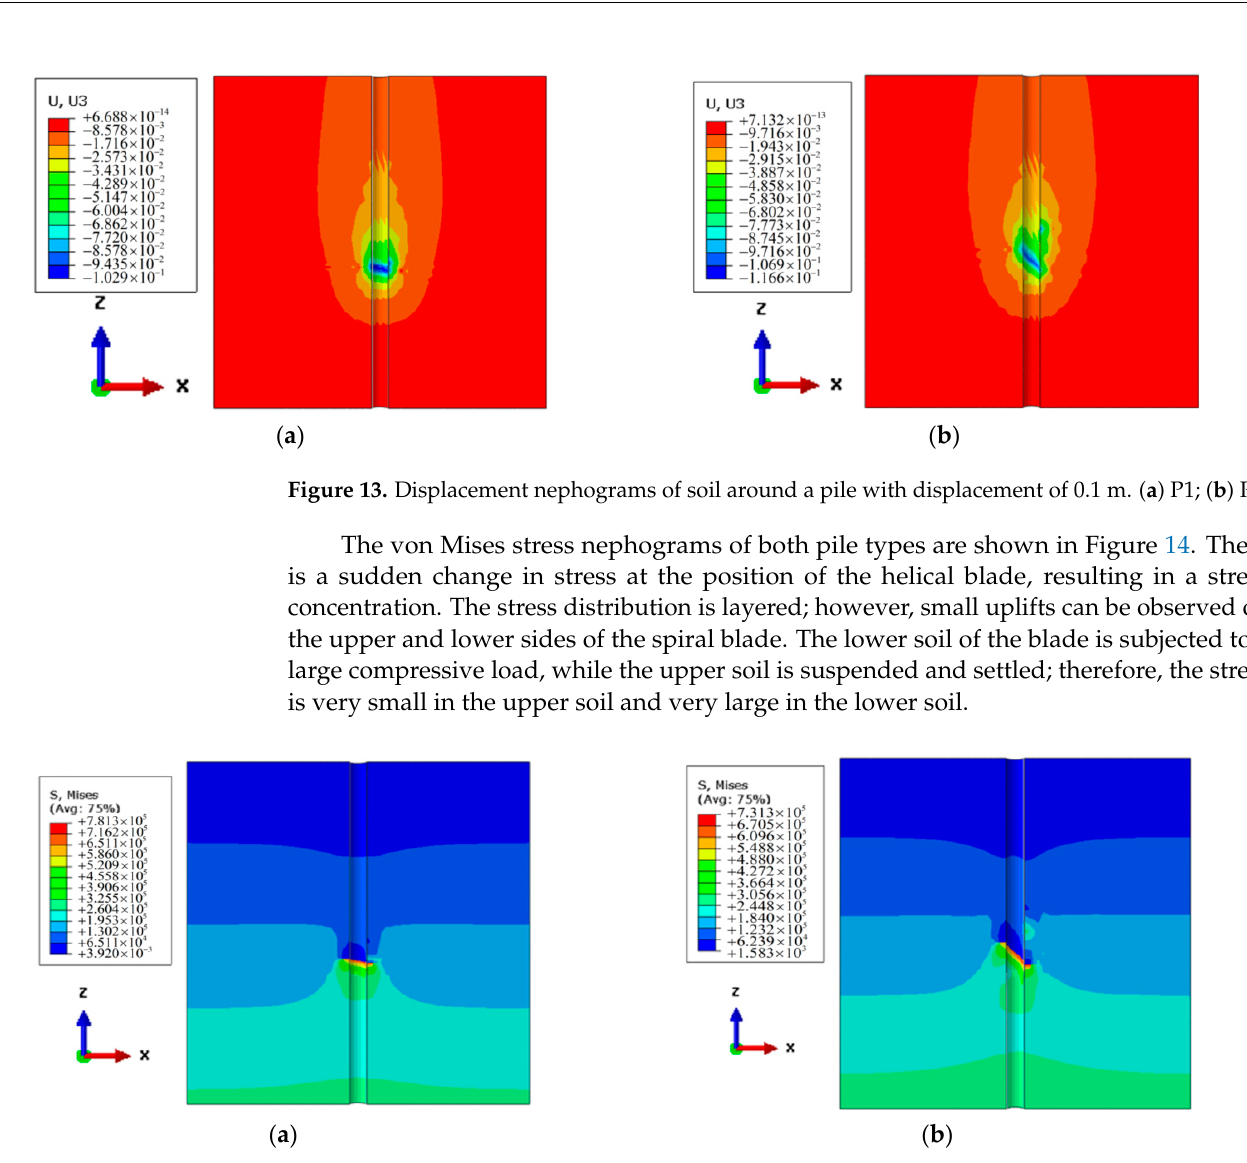
Figure 14. Von Mises stress nephograms of P1 and P2 under the same indentation displacement. ( a ) P1; ( b ) P5.